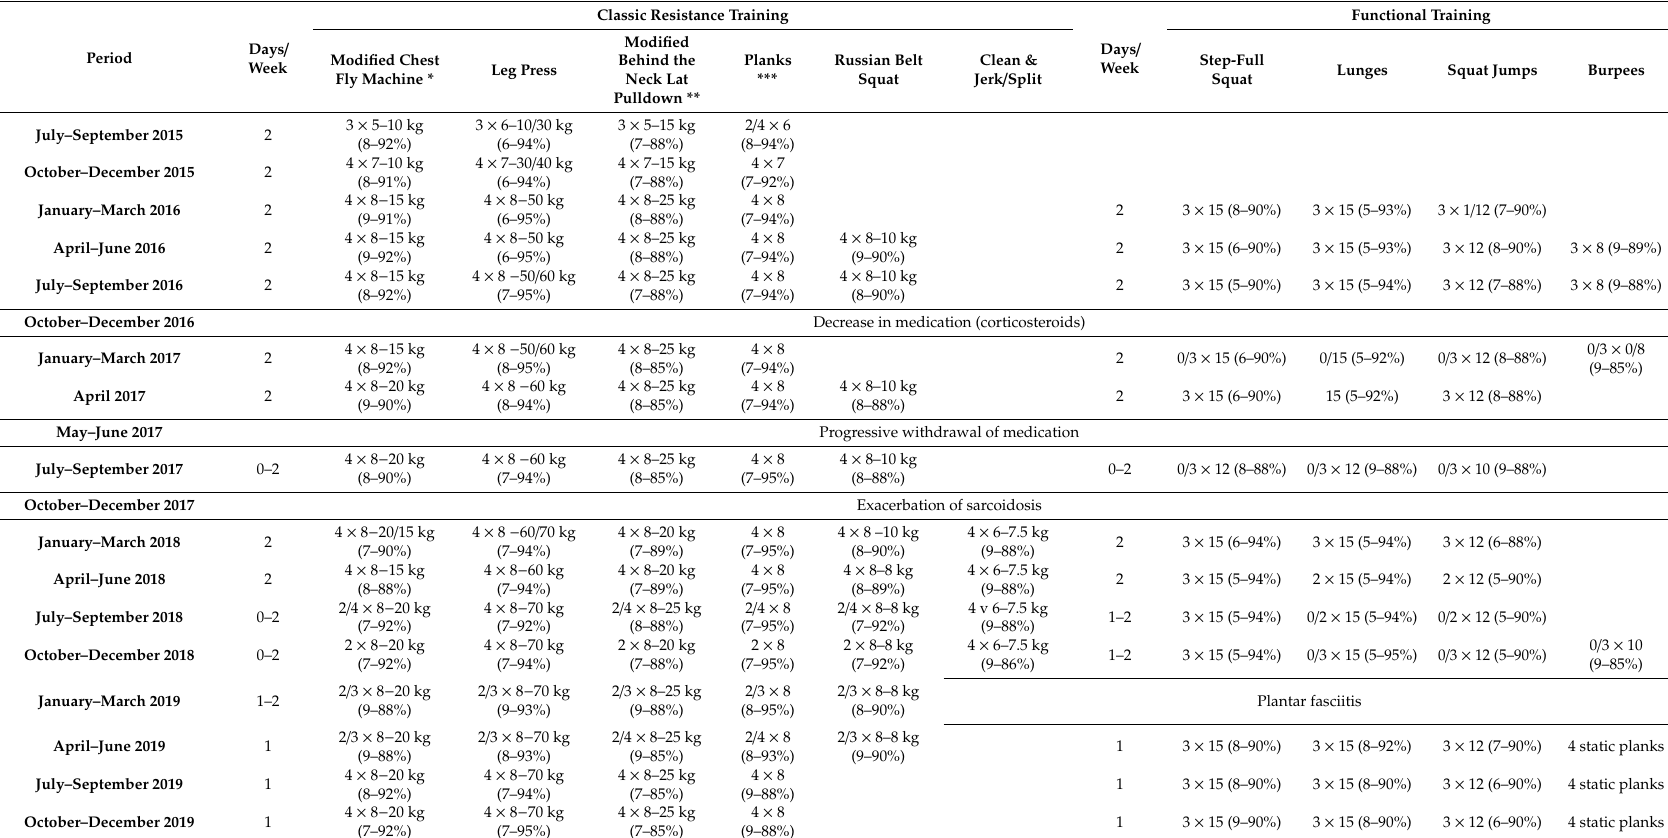
Table 2. Resistance training